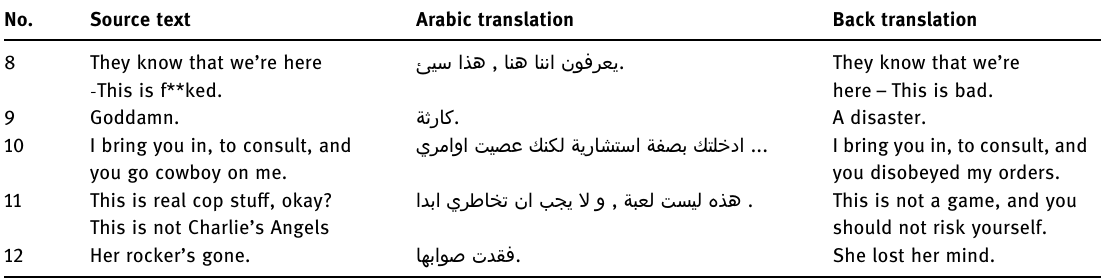
Table 9: Explicitation strategy